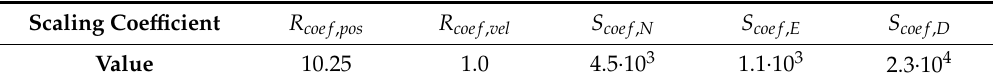
Table 1. Q and R matrices scaling coe ffi cients.